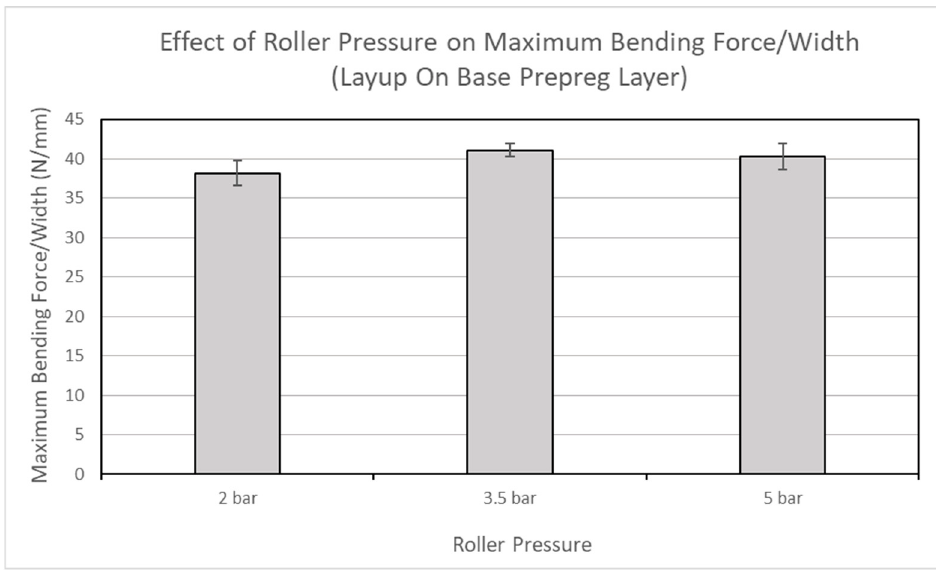
Figure 18. Effect of roller pressure and base layer on maximum bending force/width for layups on prepreg base layer.